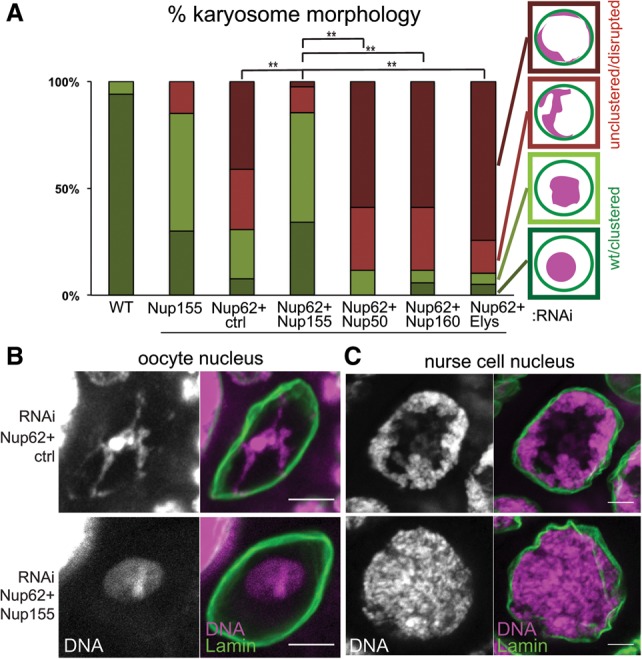
Codepletion of Nup155 rescued excessive chromatin attachment to the nuclear periphery caused by Nup62 depletion. (A) Karyosome morphology was classified into four categories, from normal to severely defective (diagrams at the right). For double RNAi of control + Nup62, Nup155 + Nup62, and ELYS + Nup62, 39 ≤ n ≤ 41; for double RNAi of Nup50 + Nup62 and Nup160 + Nup62, n = 17. The combined proportion of the two severe categories in Nup62 + Nup155 double RNAi was significantly lower than in others. (**) P = 0.0001. (B,C) Restored chromatin morphology in the oocyte (B) and nurse cell (C) nuclei upon Nup62 and Nup155 double RNAi in comparison with Nup62 and control RNAi. Bar, 5 µm.